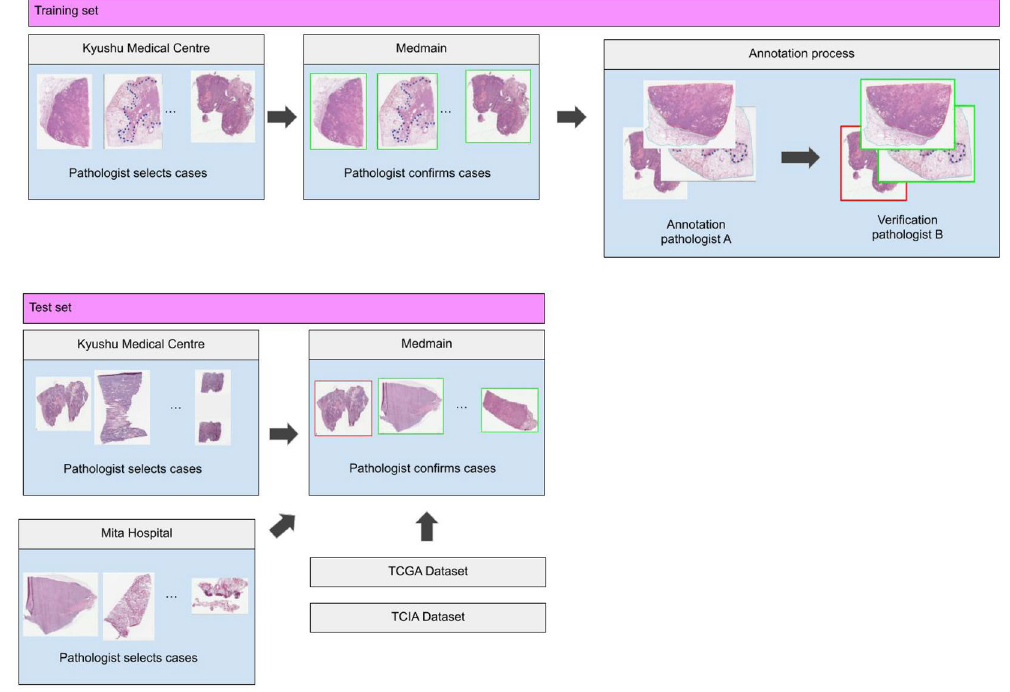
Figure 6. Overview of the data collection and annotation process for the training and test sets. Training data collected from Kyushu Medical Centre was first pre-selected by a pathologist and then sent over to Medmain for further filtering and selection. WSIs with concordant diagnoses were annotated by pathologists. For the test set, we collected WSIs from Kyushu medical centre, Mita hospital, and the publicly available TCGA and TCIA